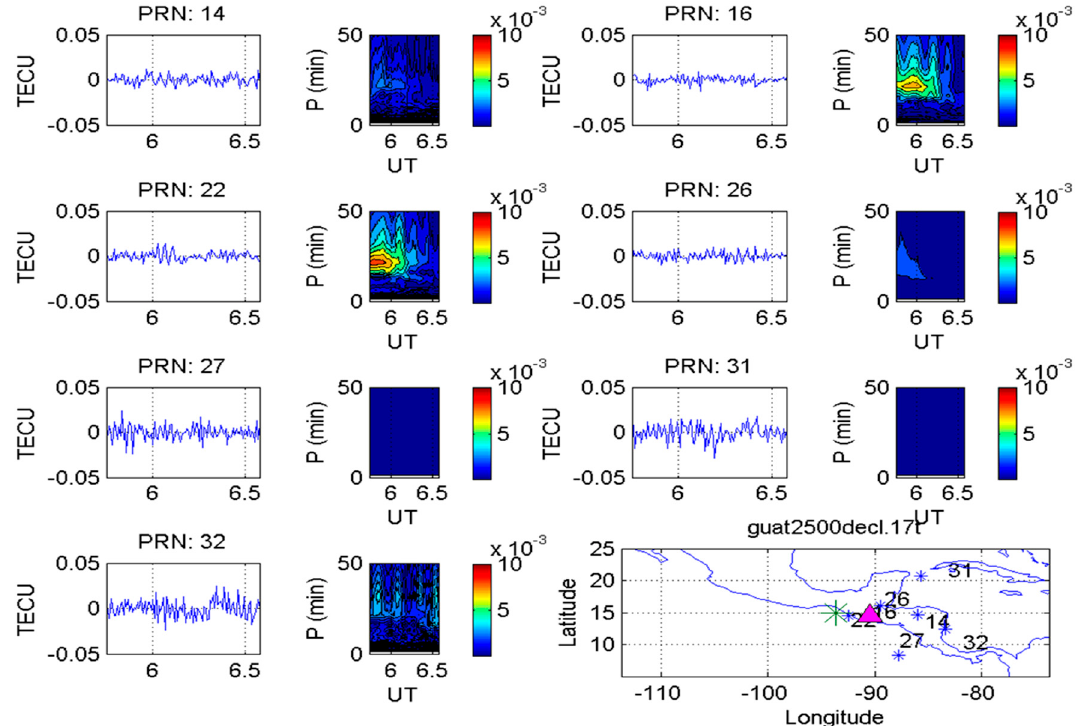
Figure 10. Fluctuations of differential slant TEC obtained from the GUAT station and PRN satellites passing over the earthquake preparation area at 5.5–6.5 UT on 7 September 2017 (DoY 250). Power spectrograms of normalized amplitude are also shown. Map shows earthquake epicenter (green asterisk), GUAT station (pink triangle), number and position of satellite (blue asterisks).